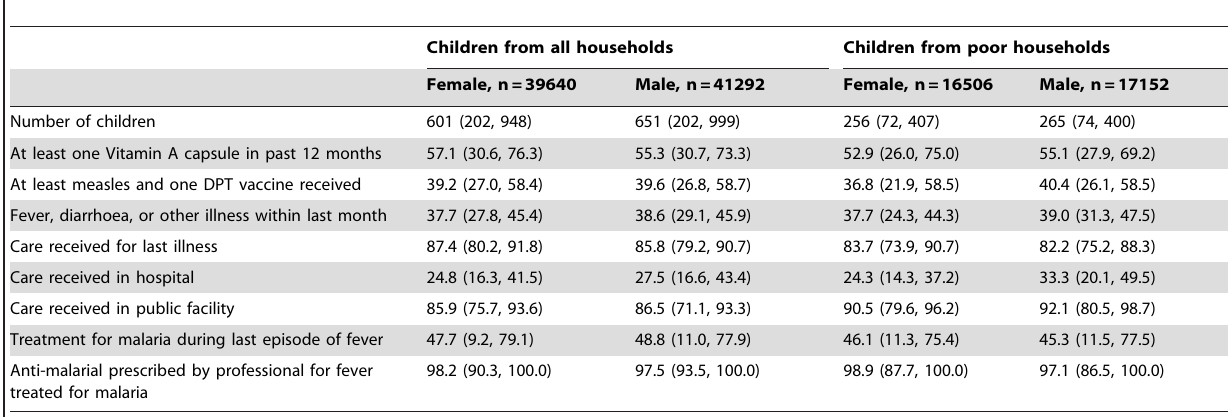
Table 3. Median (interquartile range) of percentage of children under 5 years old with access to prevention, need for and access to curative care in 53 countries.